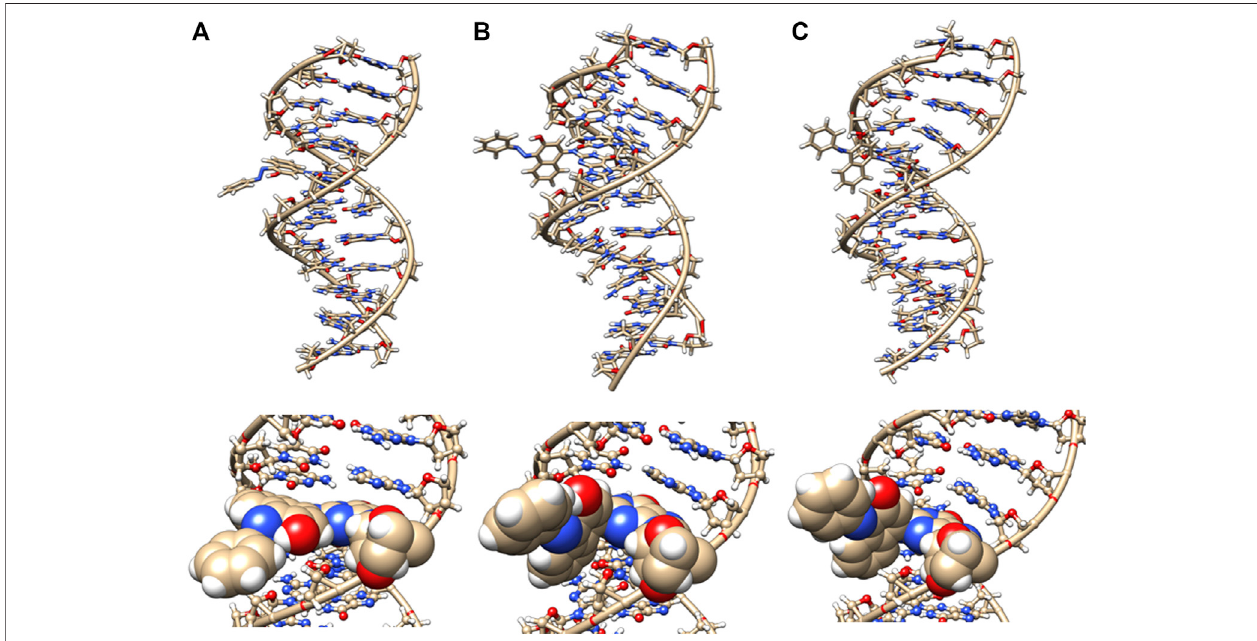
FIGURE8| DNAdodecamerwithSudanIdyeadduct. (A) Initialminimizedstructure, (B) at100 nsofMDsimulation,and (C) at1 µs.Thebottomrowisazoomed- in version of the adduct region.